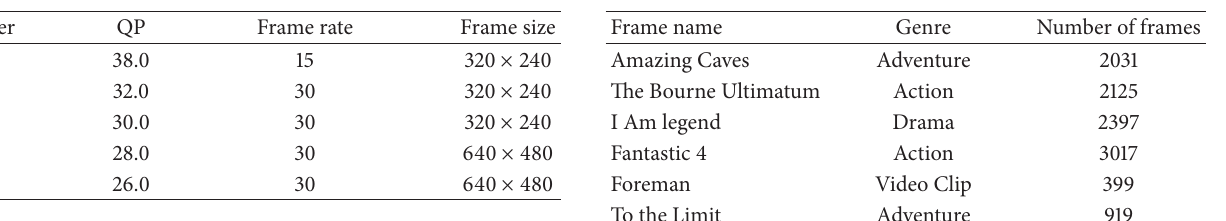
Table 2: Scalable streams. Table 3: Scalable